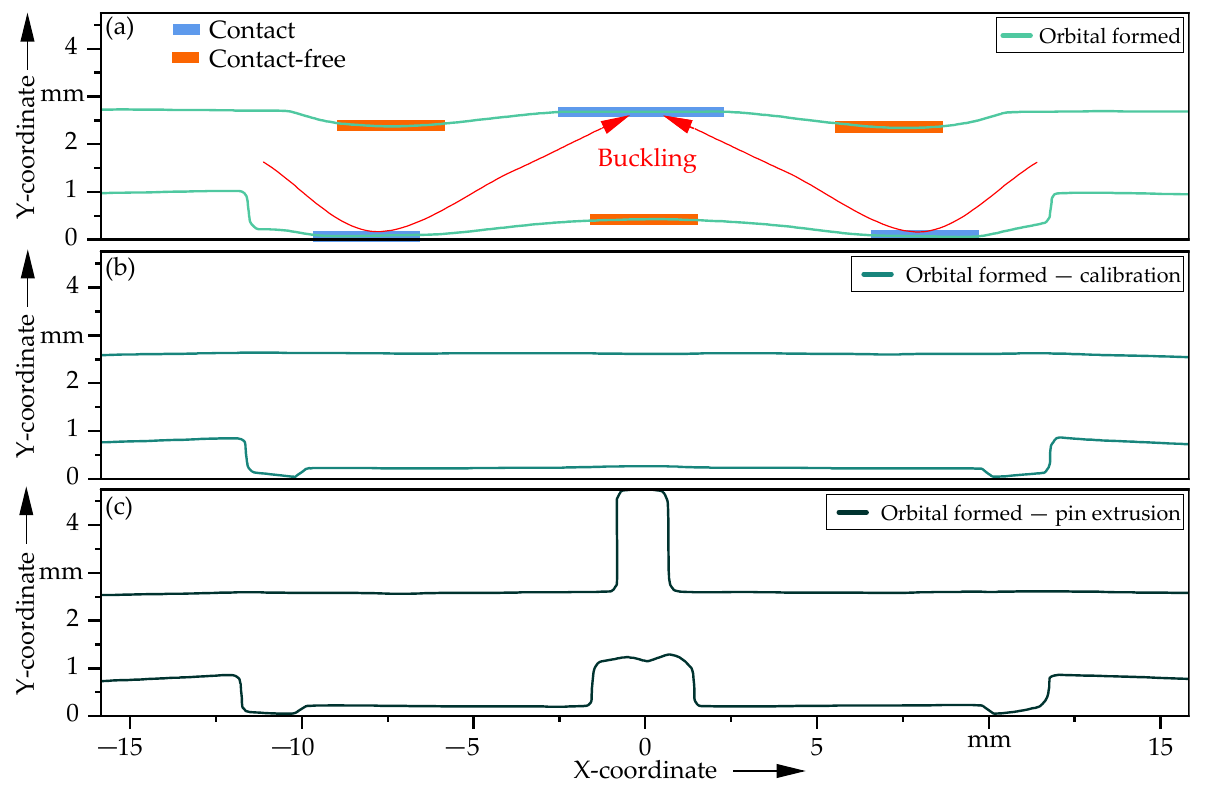
Figure 5. Surface contours of the samples for the process sequence of pin extrusion with orbital formed tailored blanks with local material pre-distribution. ( a ) First step—orbital forming ( b ) second step—calibrated specimen ( c ) third step—calibrated specimen with extruded pin structure.